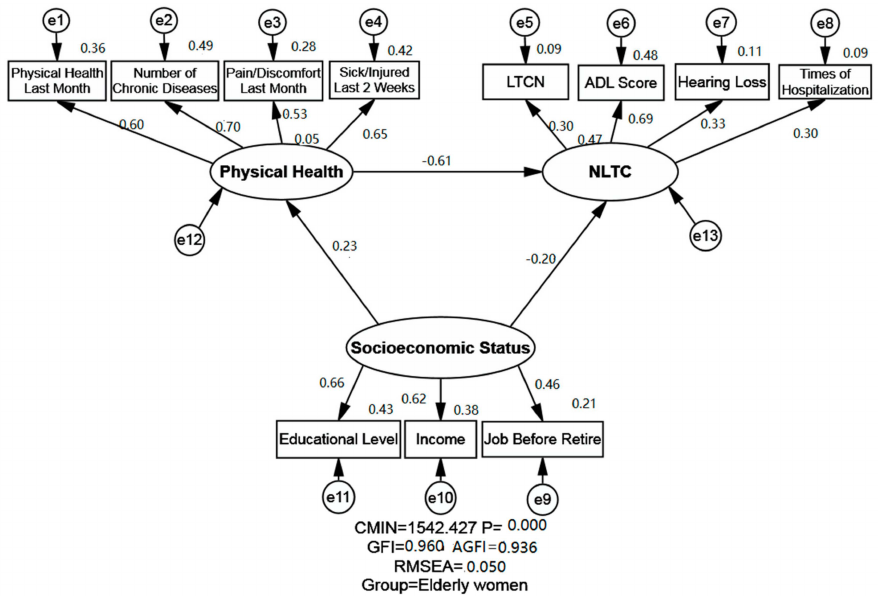
Figure 2. Structural equation modeling analysis of the association between SES, physical health and NLTC of the elderly women ( n = 7070). Employing the cross-sectional data, association between SES, physical health and NLTC were analyzed. Arrows indicate the associations and directions between variables, double curved arrows indicate correlation between each factor. All parameter estimates were statistically significant ( p < 0.001). Note: χ 2 = Chi square; GFI = Goodness of Fit Index; AGFI = Adjusted Goodness of Fit Index; RMSEA = Root-mean Square Error of Approximation; LTCN = Long-term Care Needs; SES = Socioeconomic Status; NLTC = Need for Long-term Care; CMIN: Chi-square value in Amos is called